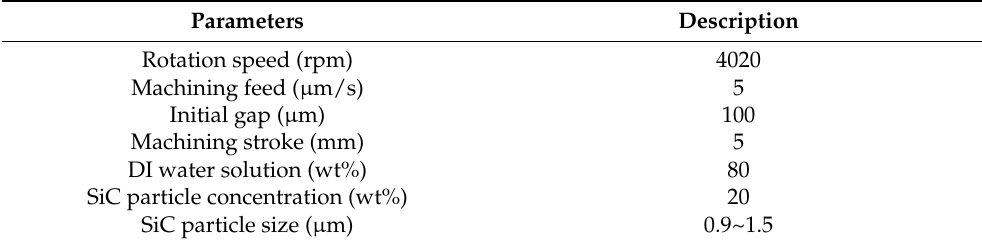
Table 6. Constant parameters and setting values of the micro hole polishing